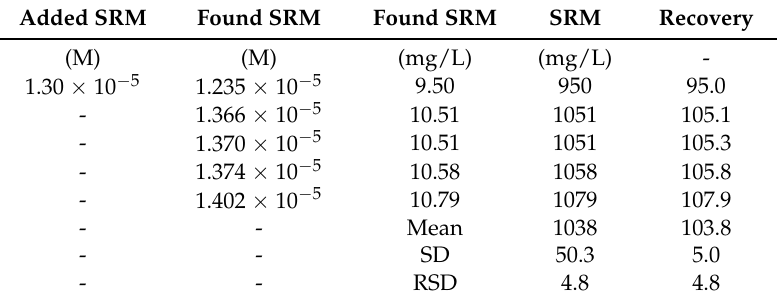
Table 5. Recovery of Al(III) SRM (1000 mg/L ± 3 mg/L) spiked to buffer solution.